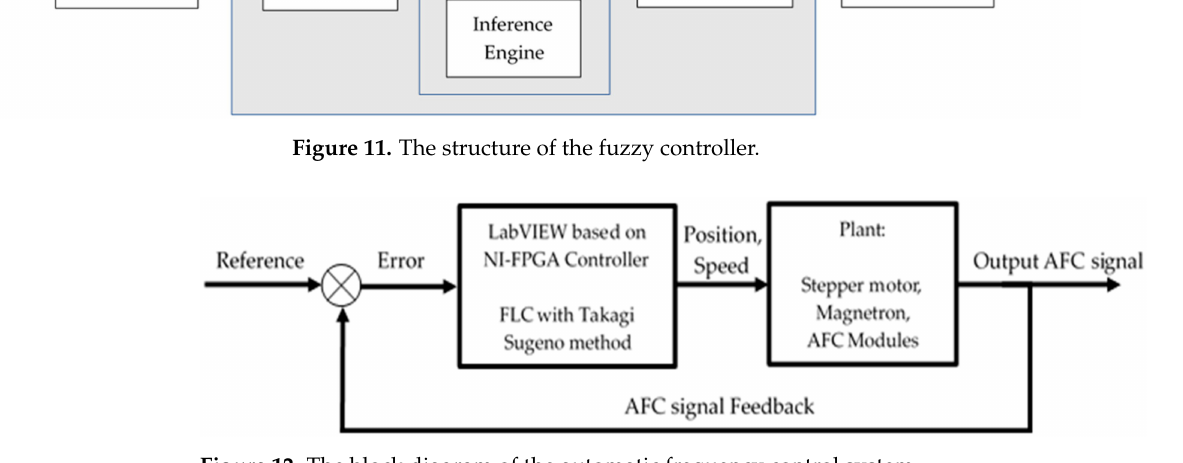
Figure 12. The block diagram of the automatic frequency control